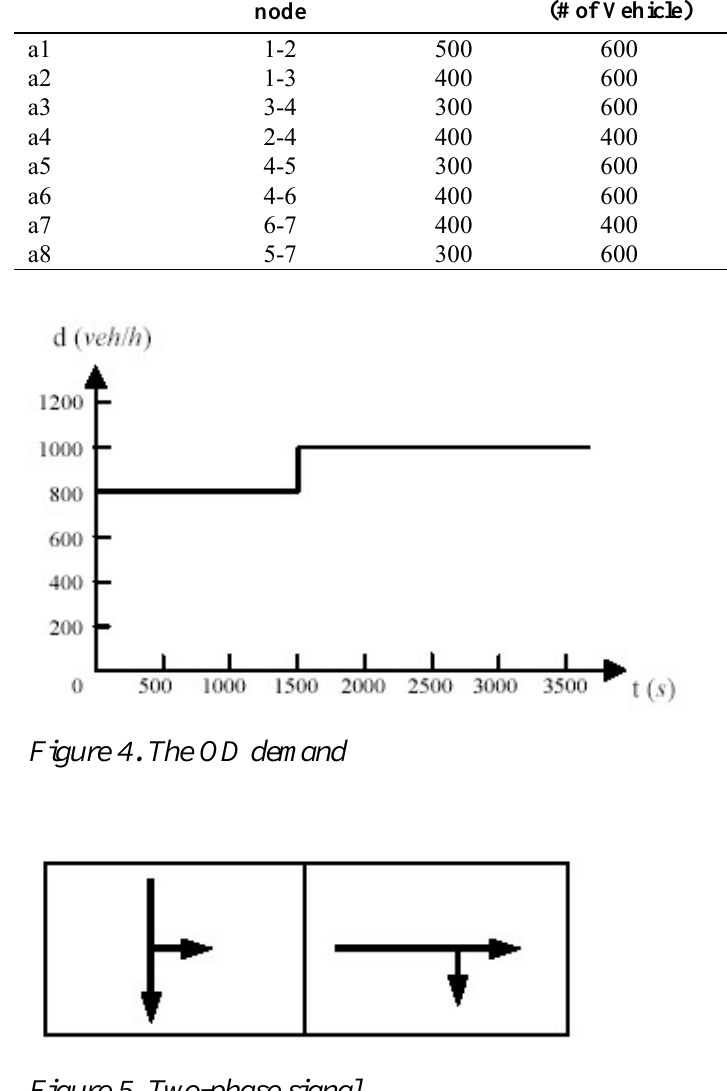
Figure 5. Two-phase